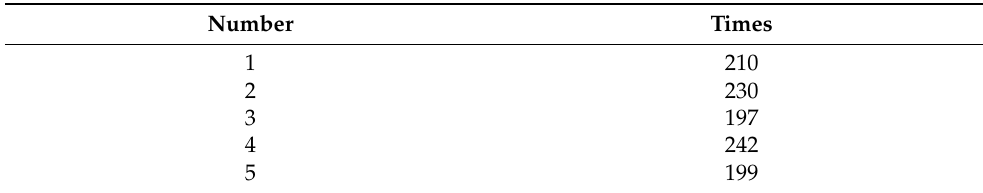
Table 2. Determination of airtightness of soft fingers.